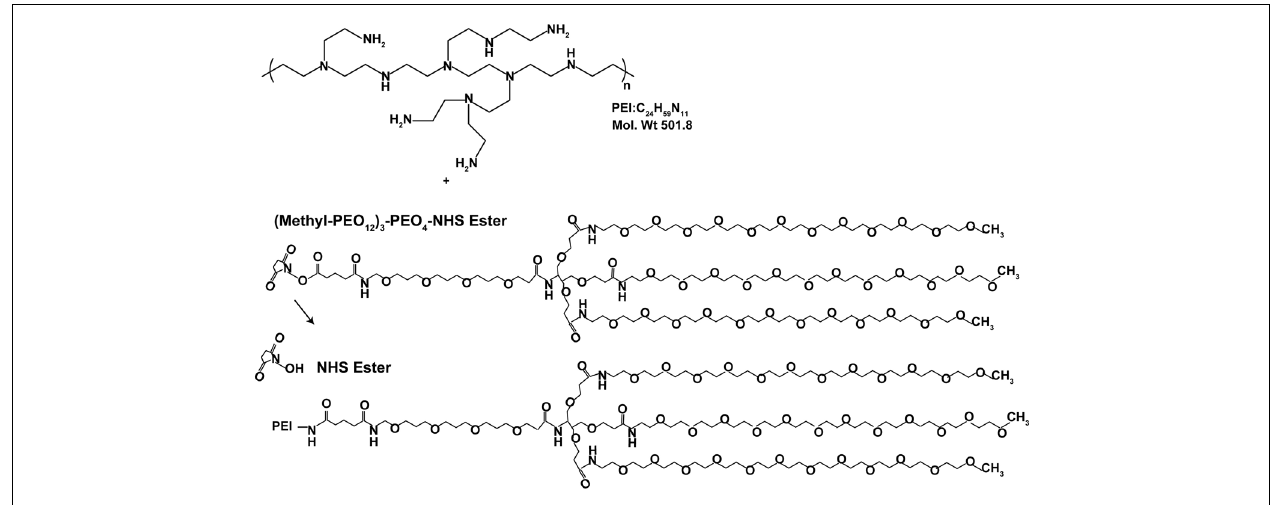
FIGURE 1 | Stepwise synthesis of PEGylated